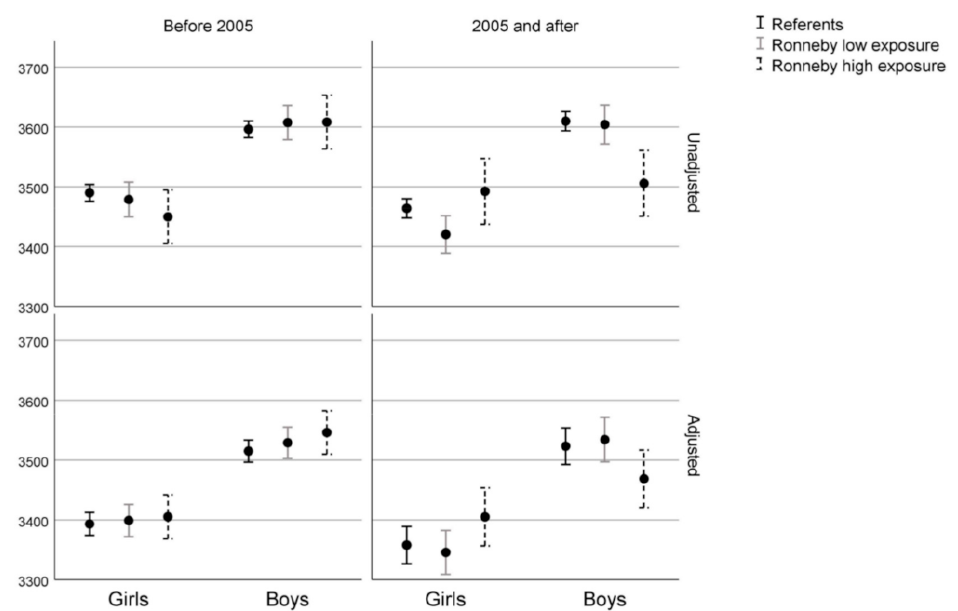
Figure 2. Mean birth weight with 95% confidence intervals stratified for infant sex and period (before or after 2005). Adjusted models include parity, maternal civil status, education level, maternal age, gestational age, smoking habits and BMI in early pregnancy.